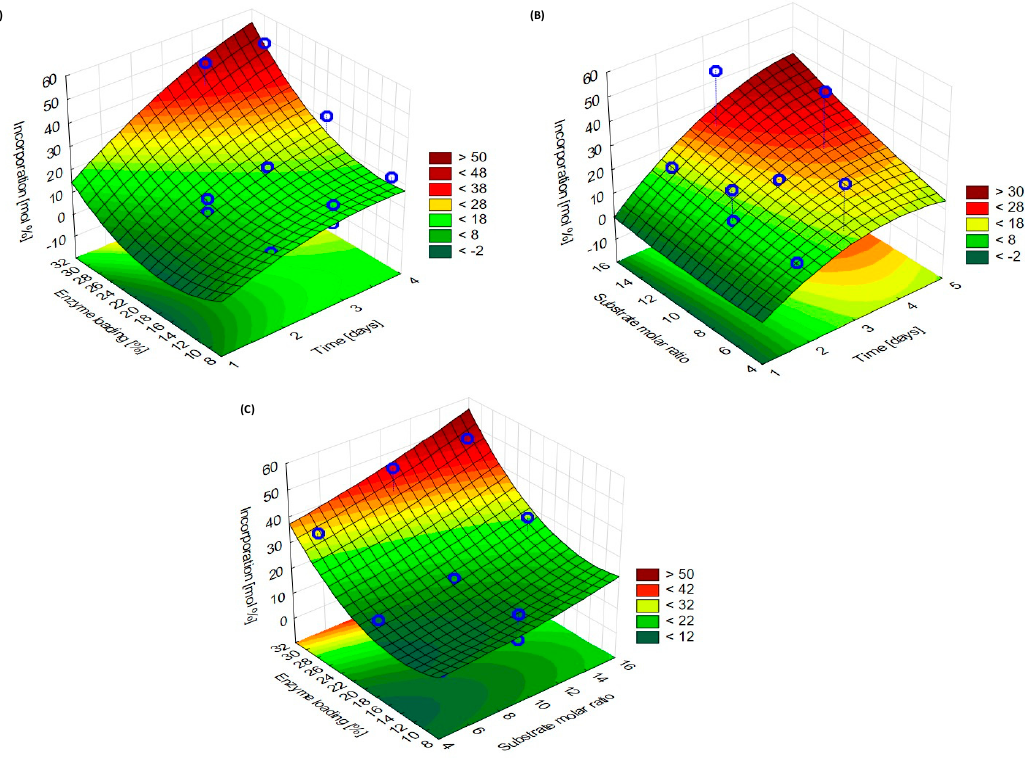
Figure 5. Response surface plots presenting effect of ( A ) enzyme loading and time of reaction, ( B ) substrate molar ratio and time of reaction, ( C ) enzyme loading and substrate molar ratio on the incorporation of 3-OMe-CA into phospholipid